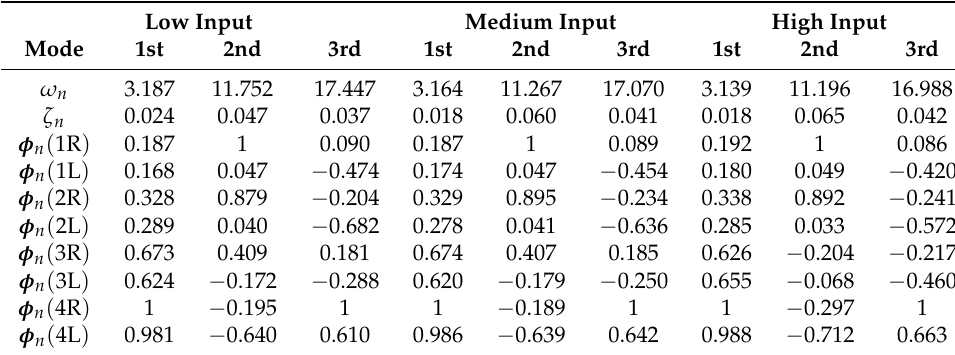
Table A4. Full wing: identified modal